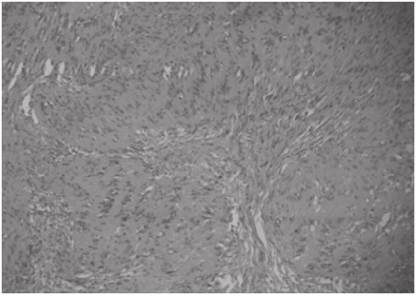
Figure 3. Antoni A and Verocay bodies seen (H&E staining)